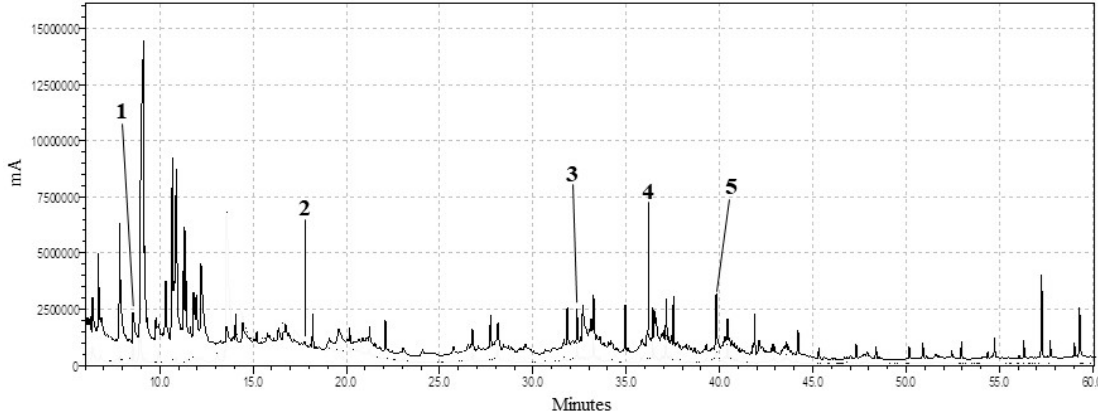
Figure 3. Total ion chromatogram. Peaks corresponding to chemical markers identified in the dental calculus of one individual (Burial 20) were indicated (1, alpha-pinene; 2, sabinol; 3, hexadecanoic acid; 4, octadecanoic acid; 5, dehydroabietic acid).